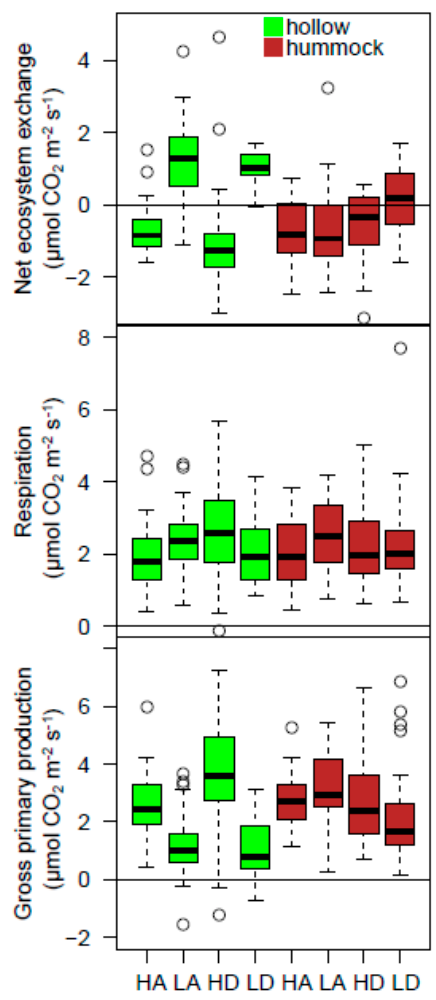
Figure 2. Boxplots of fluxes in response to experimental treatments. The treatment labels are “H” = high water tables, “L” = low water tables, “A” = average rainfall, “D” = droughted rainfall. Green boxes are hollows, brown boxes are hummocks. Box intervals represent the first and third interquartile range, whiskers represent the minimum and maximum after removing outliers, and the horizontal bold line represents the median.